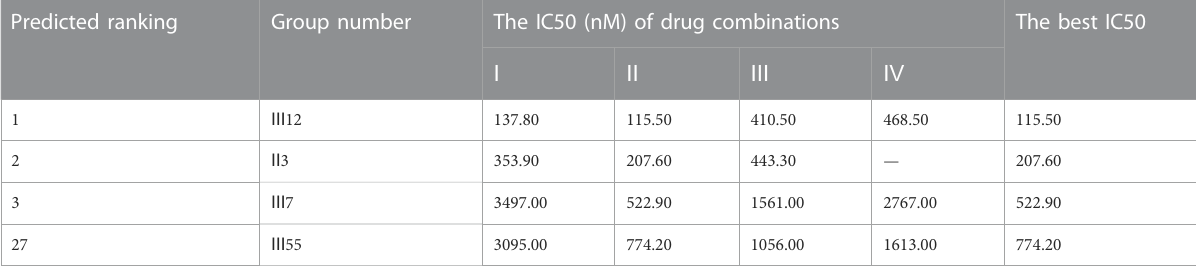
TABLE 7 The anti-cancer effects of drug combinations on MDA-MB-468 cells. Predicted ranking Group